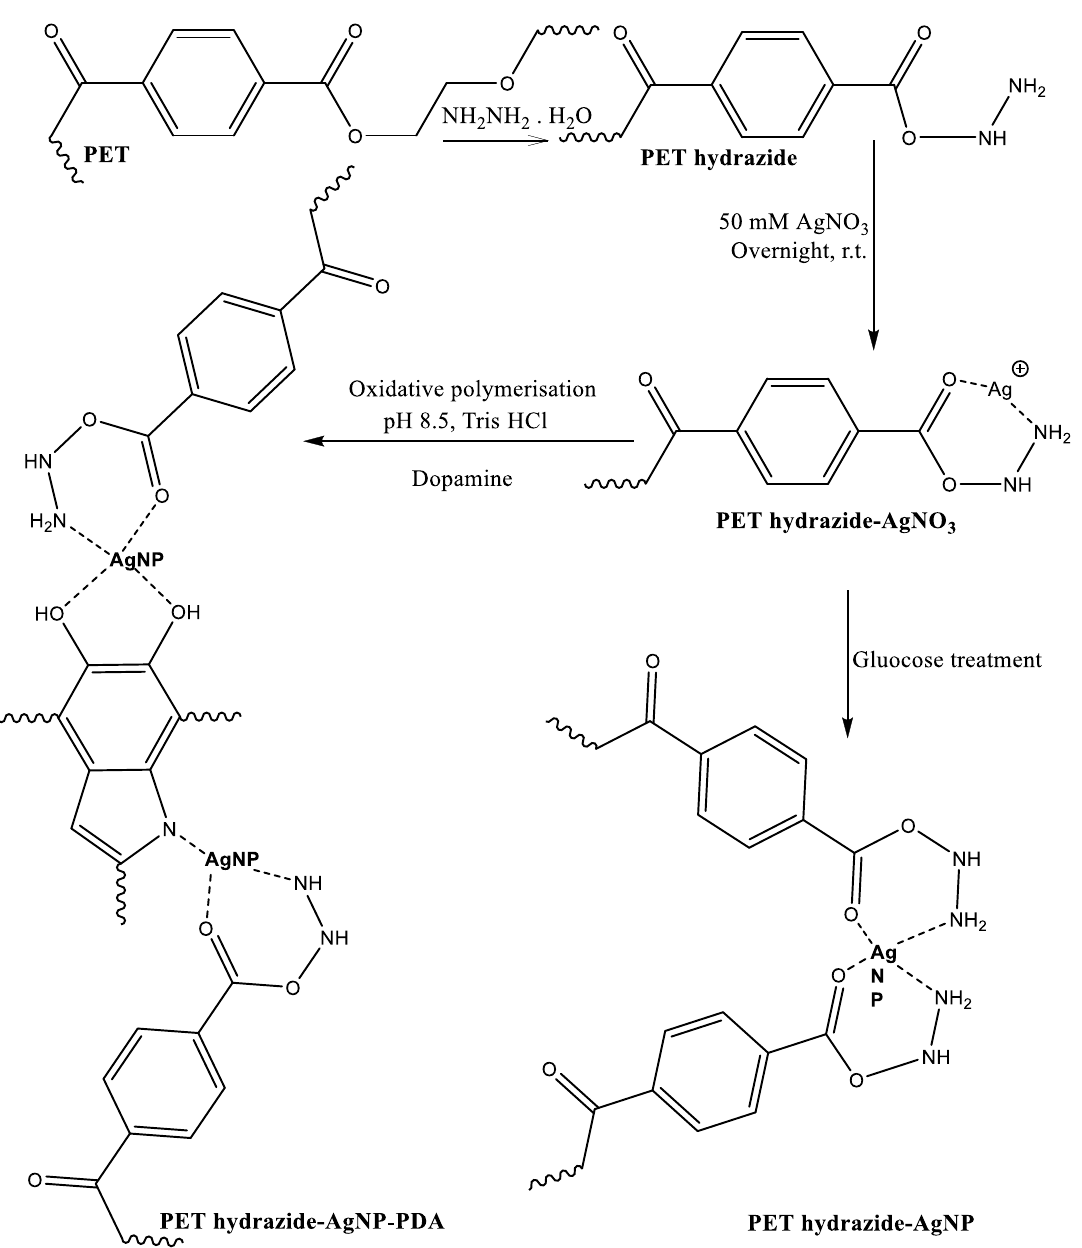
Figure 1. Schematic representation for the synthesis of PDA-coated, AgNPs-loaded polyester hy- drazide and AgNPs-loaded polyester hydrazide.